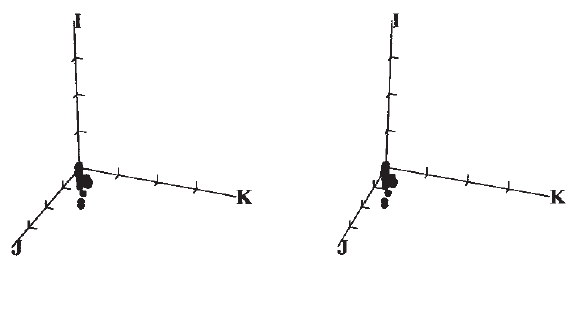
Figure 4a. Two hundred measurements of refractive state of a test eye are shown on one set of axes. Axis length: 1